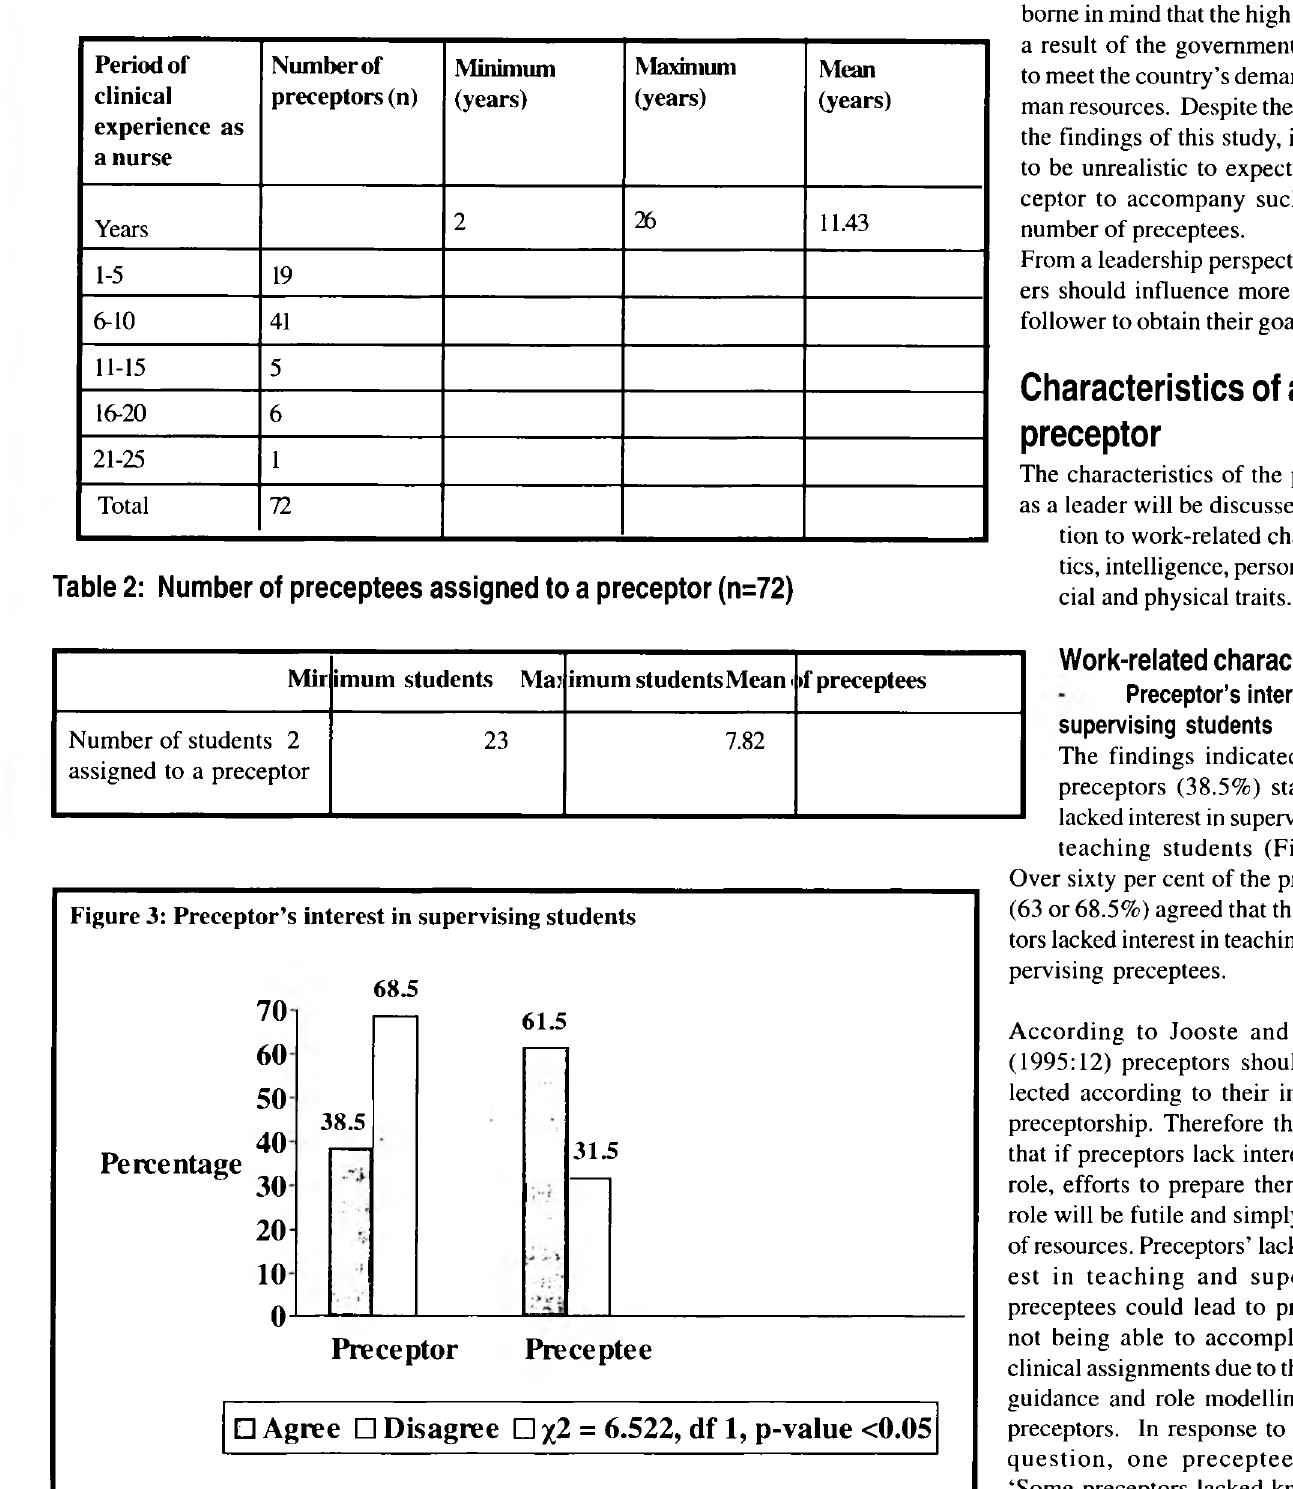
Table 1: Clinical experiences of preceptors